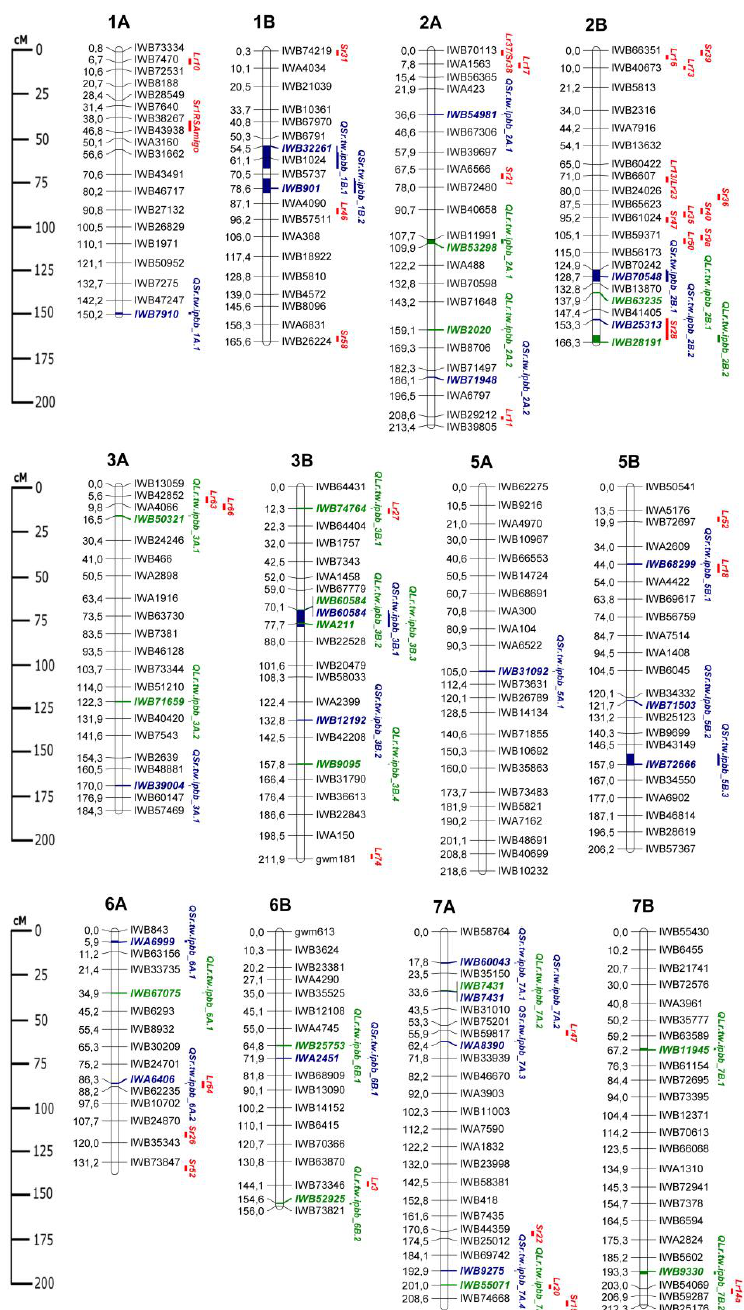
Figure 3. Genetic map of QTLs associated with resistance to leaf rust (LR) and stem rust (SR), as well as some possible candidate resistance genes. The SNP names are shown on the right and marker positions are shown on the left of the chromosome, in centimorgans (cM). Significant markers, the QTLs identified in this study, and potential candidate resistance genes are highlighted in color: red for genes, green for LR QTLs, and blue for SR